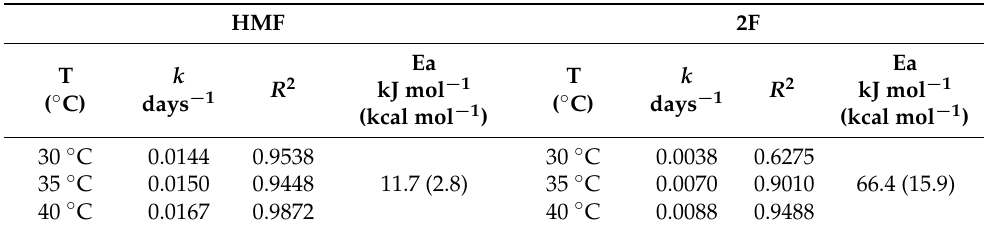
Table 7. Kinetic parameters for 5-hydroxymethylfurfural (HMF) and 2-furaldehyde (2F) formation in MdL stored under different temperatures (30, 35, 40 ◦